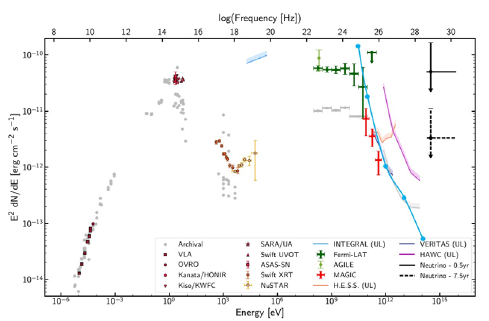
to few hundred TeV.